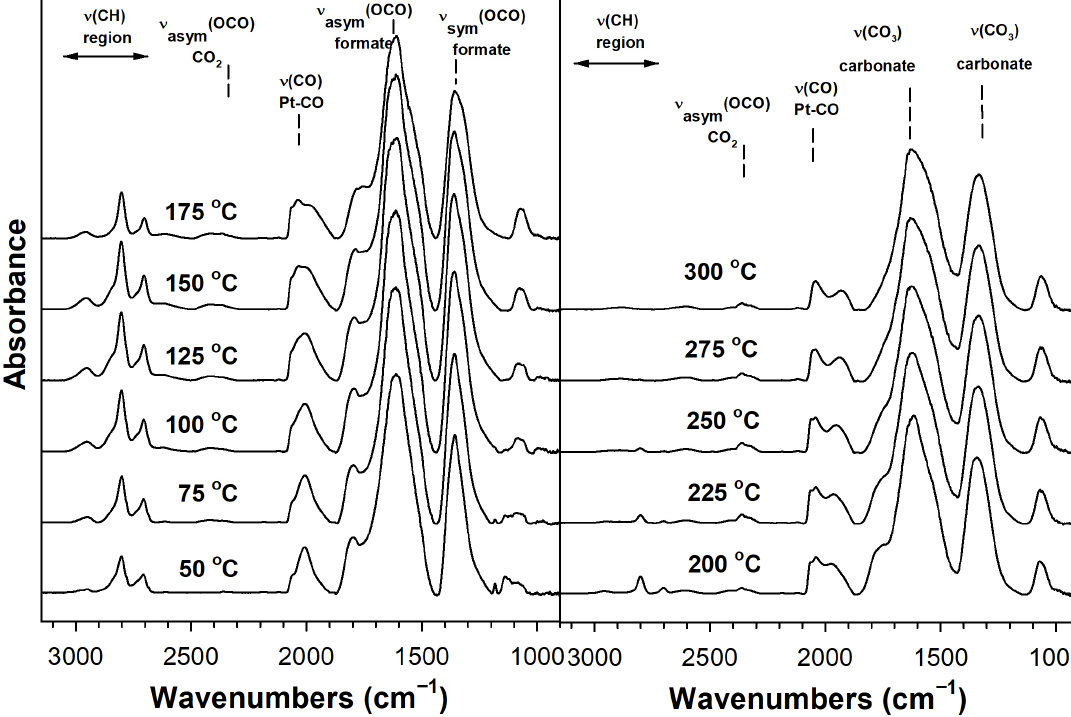
Figure 6. DRIFTS of steam reforming of formaldehyde over 2.5%Na-2%Pt/m-ZrO 2 .